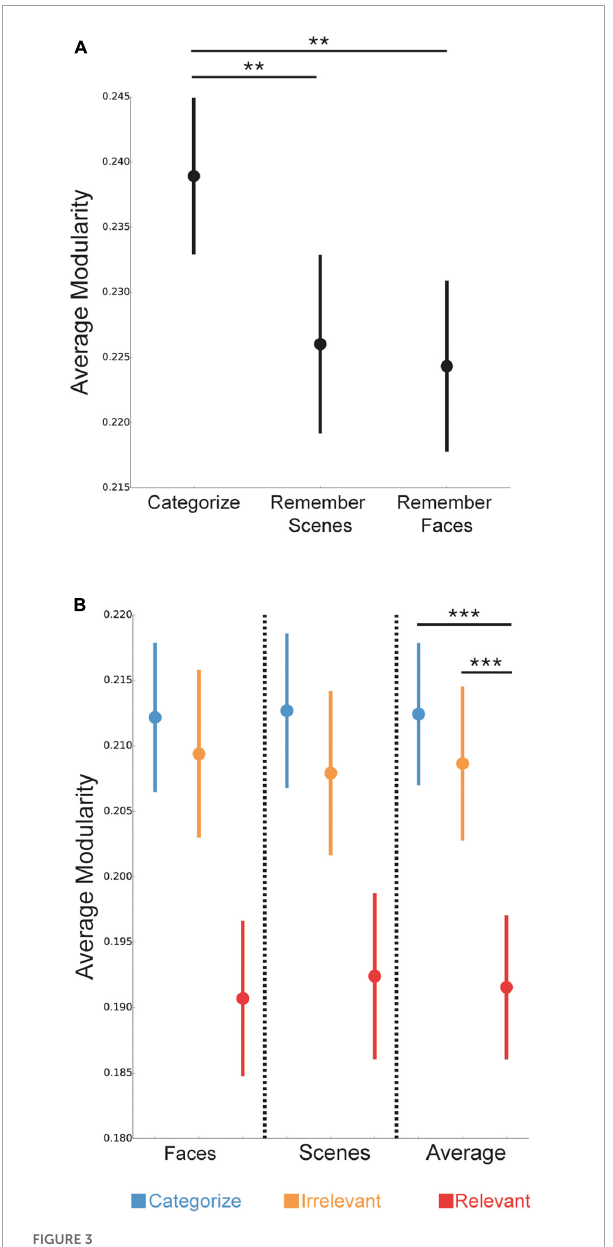
FIGURE3 Differences in network modularity based on task condition and stimulus goals. (A) Network modularity was lower during the Remember Scenes and Remember Faces (1-back) conditions compared to the Categorize (0-back) condition. (B) Within the three task conditions, network modularity was selectively lower for trials with relevant stimuli (red) compared to trials with irrelevant (orange) or categorized (blue) stimuli. P-values are presented as the average of face and scene stimuli in panel (B) , as there was a main effect of stimulus goals, but no interaction between stimulus goals and stimulus type. Data are presented as mean ± SEM. ***P < 0.001; **P <